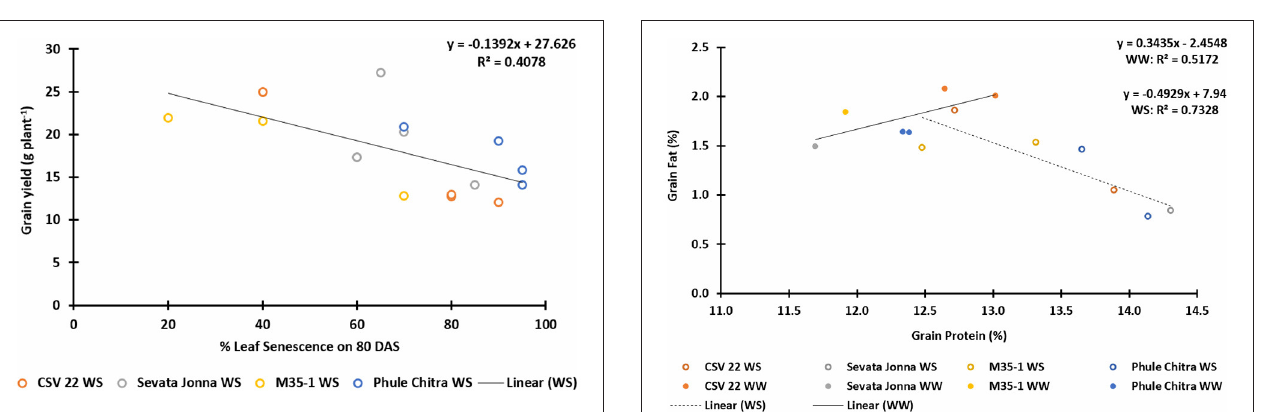
FIGURE 7 | Quality trait relationship between grain fat and protein content in water stressed (WS) and well-watered (WW) plants across four genotypes tested in 2019–20 lysimetric trial. Crop varieties are color coded; Full circles (•) indicate WW plants; Open circles (O) indicate WS plants; solid line (—) indicates relationship in WW plants; dashed line (—–) indicates relationship in WS plants.